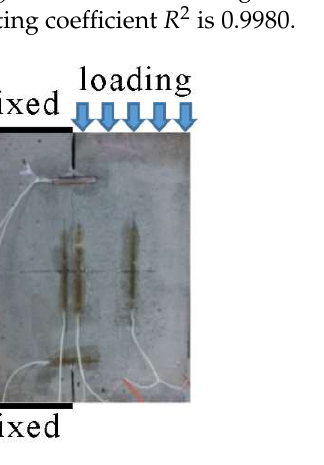
Figure 4. Linear relation of K ΙΙ C and c (modified from [49]). In this test, the interface crack is in a pure shearing state. For this condition, the proposed fracture criterion can be generated as the following expression: 2 C